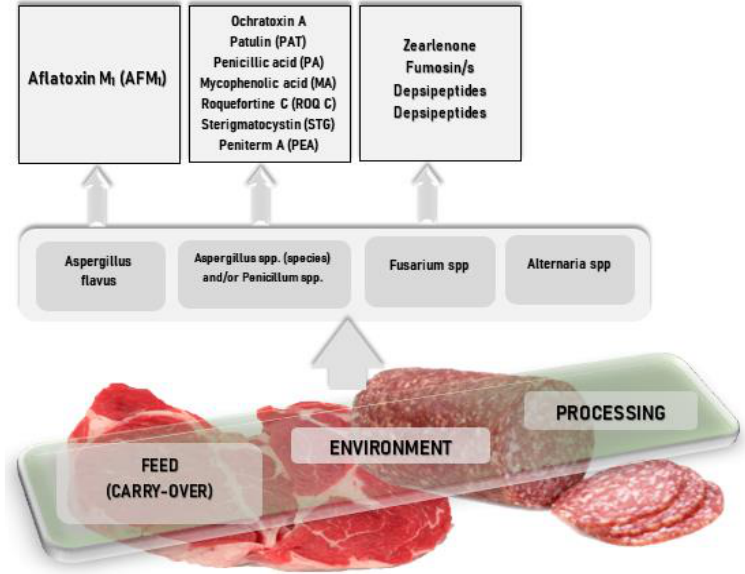
Figure 1. Main mycotoxins associated with animal products.